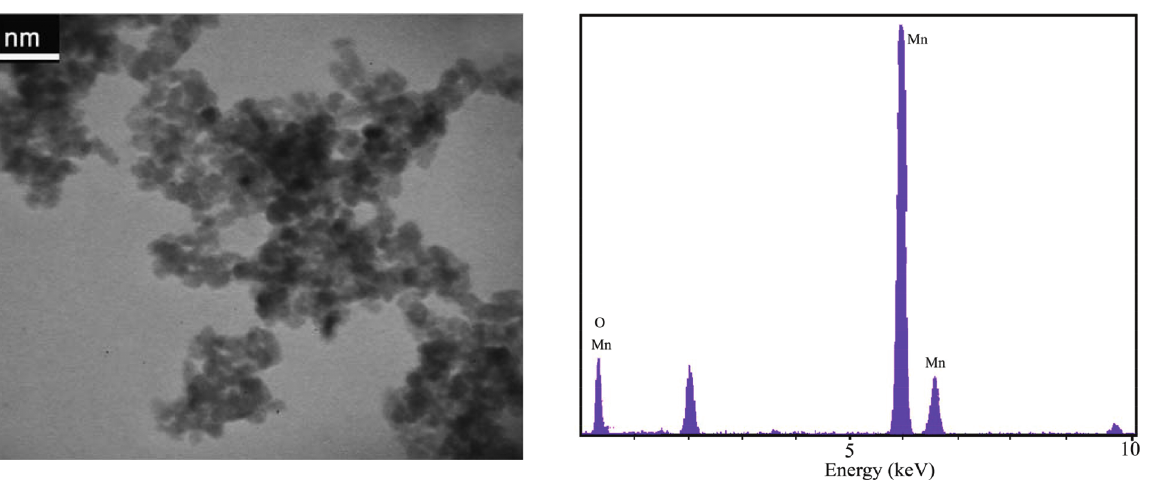
Figure 7: EDS pattern of MnOOH (sample no.